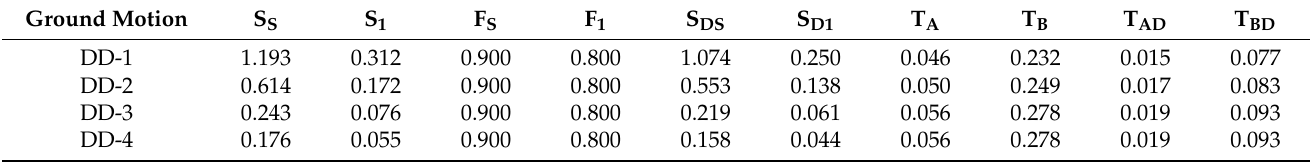
Table 6. Comparison of earthquake parameters for different probability of exceedance levels.